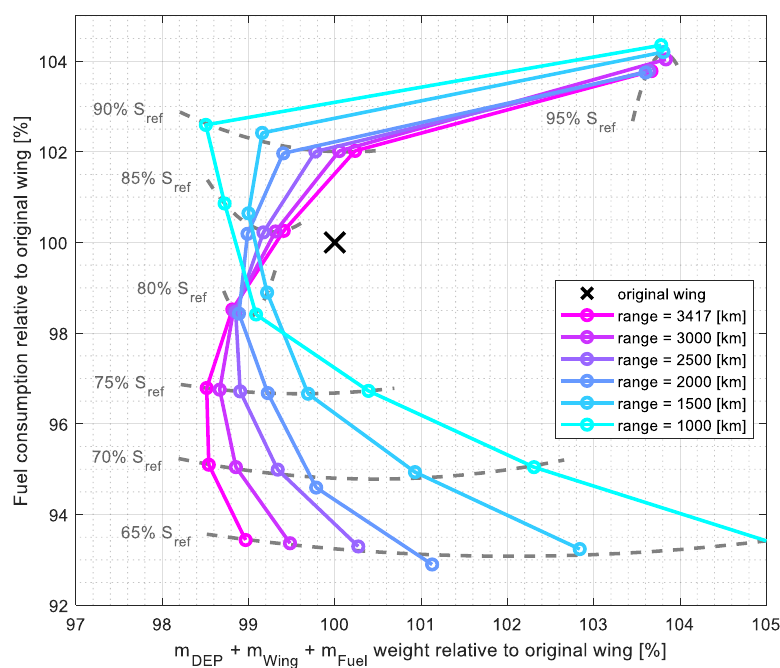
Figure 13. Relative fuel consumption for different wing configurations.